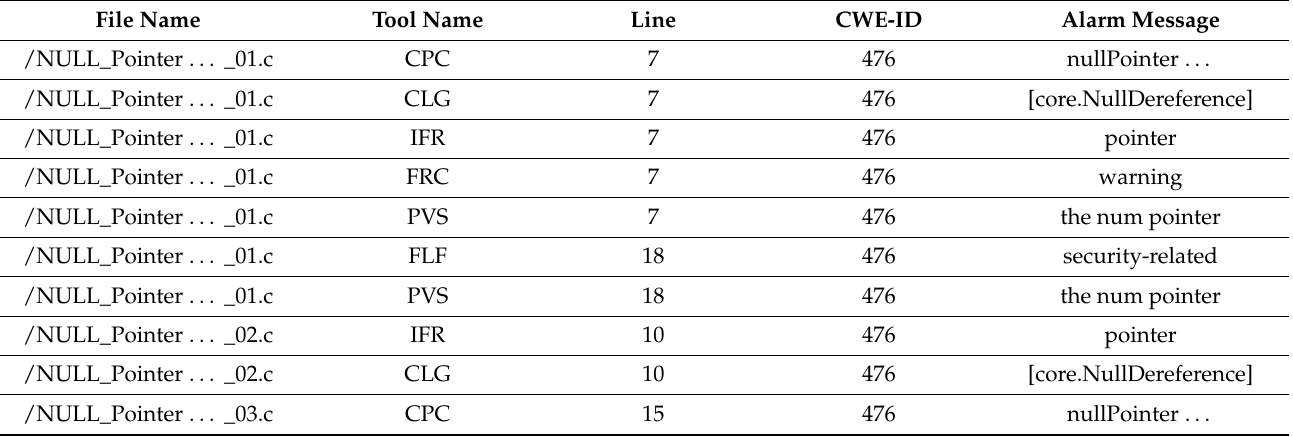
Table 3. Example analysis result of weakness multiple static analysis tools with